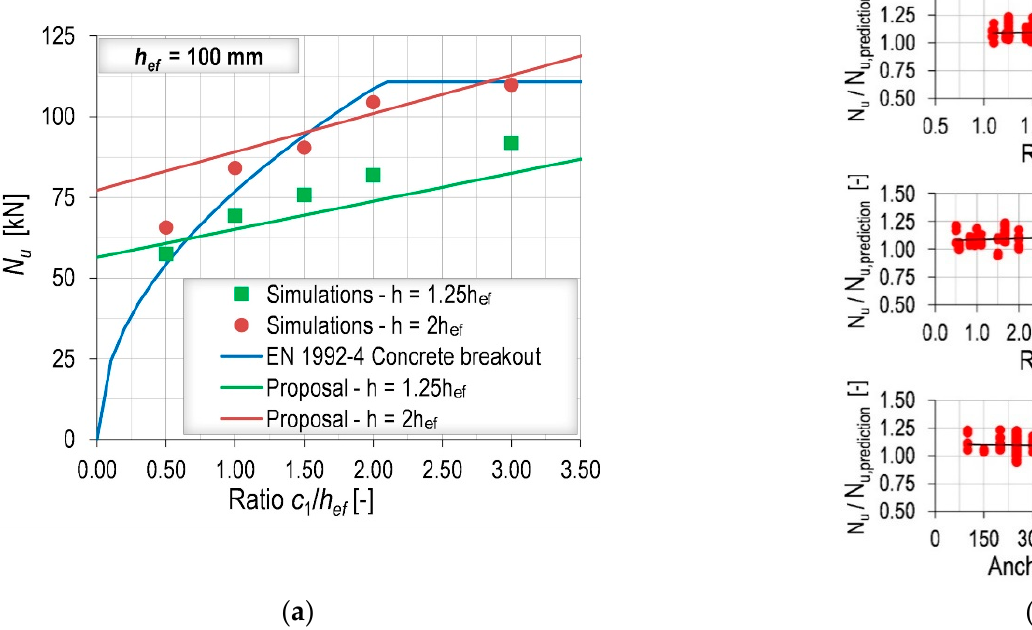
Figure 9. ( a ) Illustration of the principle of the modified design proposal; ( b ) Numerical results compared to the modified design proposal as a function of investigated parameters.